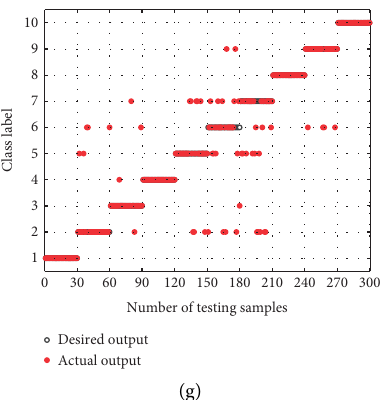
Figure 9: The recognition results corresponding to different feature extraction methods.